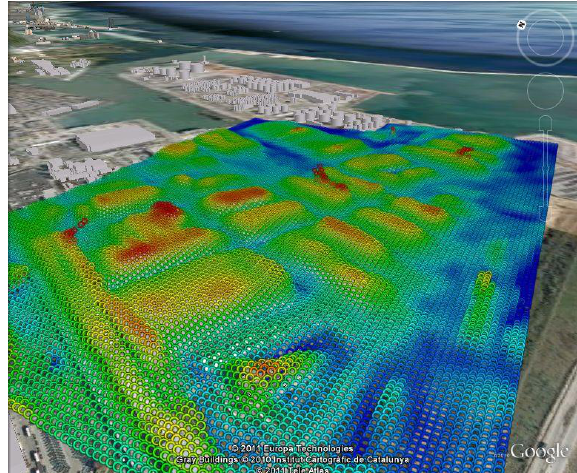
Figure 7. Selected buildings on industrial area of Barcelona Figure 8. DSM in industrial area on Google Earth (Goldstein)